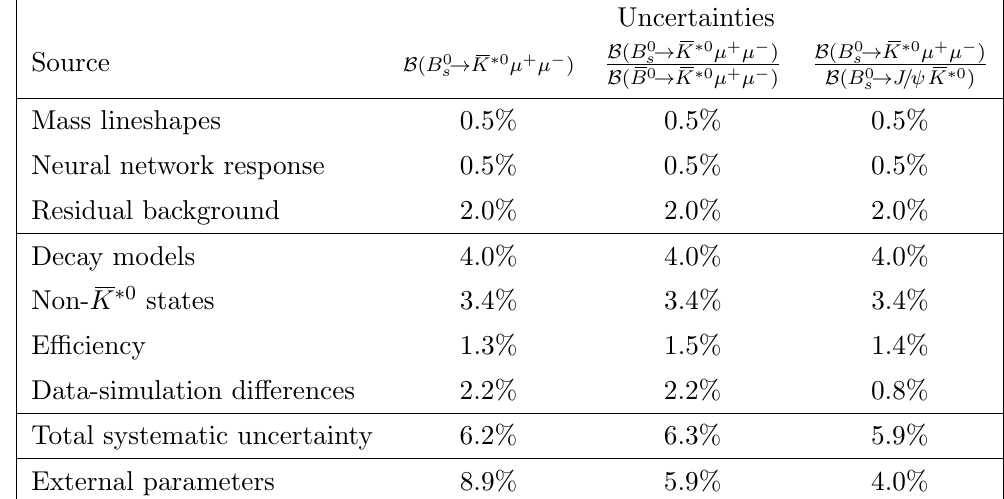
Table 1 . Main sources of systematic uncertainty considered on the branching fraction measure- ments. The (cid:12)rst uncertainty applies to the measurement of B ( B 0 B ( B 0 ! K (cid:3) 0 (cid:22) + (cid:22) (cid:0) ) = B ( B 0 ! K (cid:3) 0 (cid:22) + (cid:22) (cid:0) ) and the third to B ( B 0 s respectively. A description of the di(cid:11)erent contributions can be found in the text. The (cid:12)rst three sources of uncertainty a(cid:11)ect the measured yield of the signal decay. The total uncertainty is the sum in quadrature of the individual sources. The (cid:12)nal row indicates the additional uncertainty arising from the uncertainties on external parameters used in the